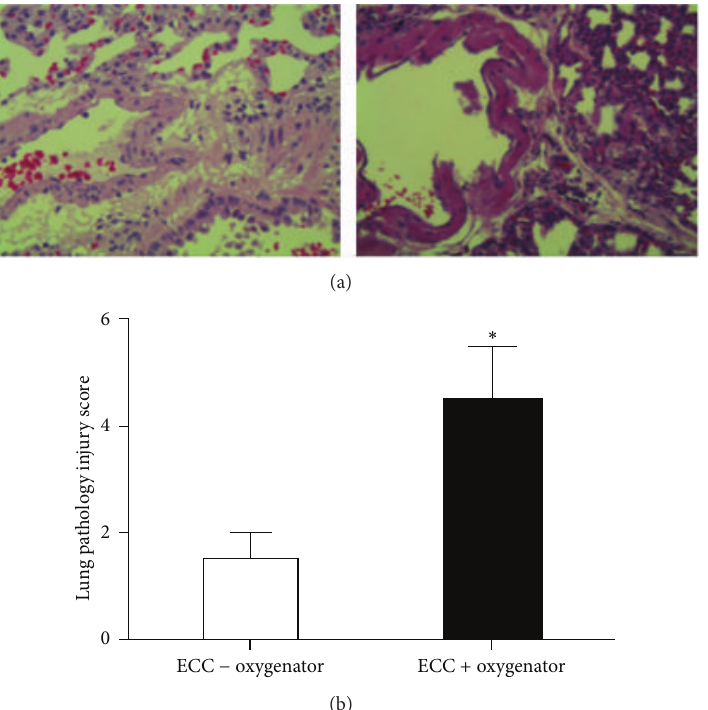
Figure 4: Lung injury. Representative histological images (magnification 40x) of right lung fixed in formaldehyde, sectioned, and stained with haematoxylin and eosin (a). The acute lung injury score was calculated (b). ∗ 𝑃 < 0.01